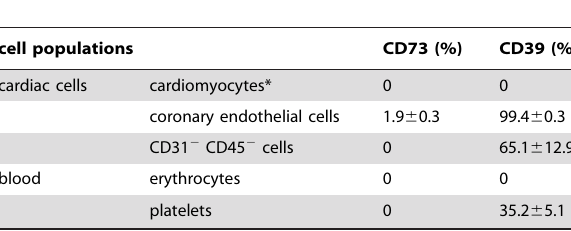
Table 1. Expression of CD73 and CD39 on cardiac cells and circulating blood cells under basal conditions (n= 4–5).